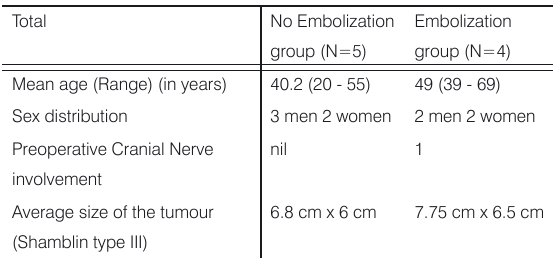
Table 1. Characteristics of the